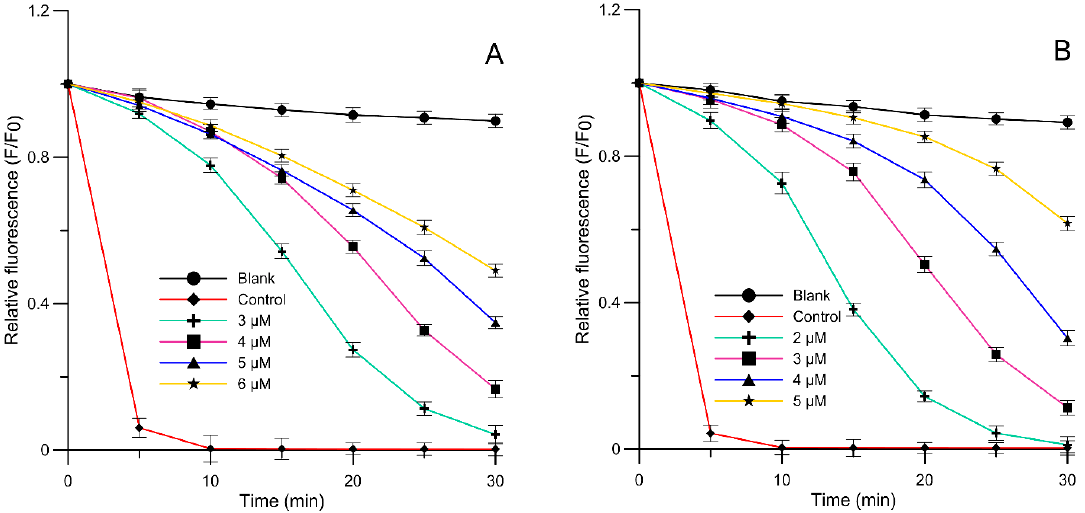
protection against free radicals induced by AAPH. Only a slight difference in IC 50 of Q and Q 7-MeGlu